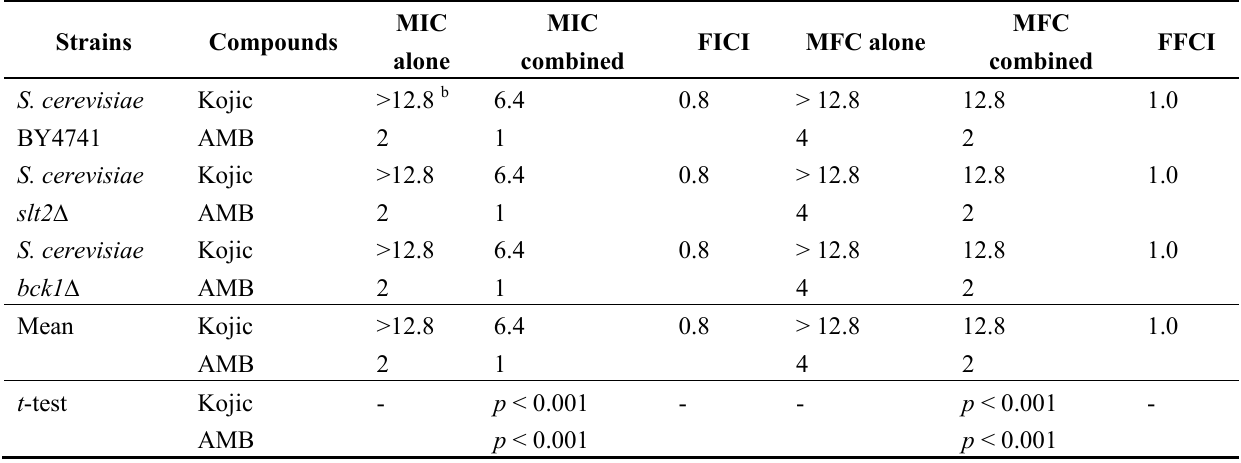
Table 4. Antifungal chemosensitization of kojic acid (mM) with AMB (µg/mL). a MFCs are concentrations where ≥ 99.9% fungal death was